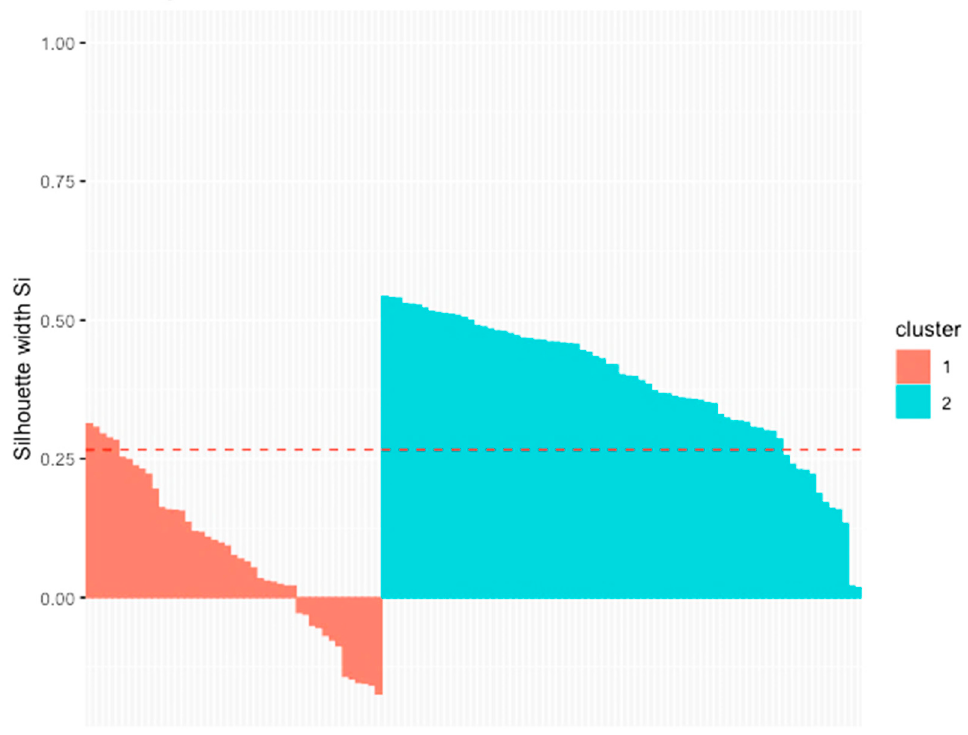
Figure 3. Cluster silhouette plot for categorization of piglets in two clusters based on their suckling and rearing behavior; dashed line = average S i .